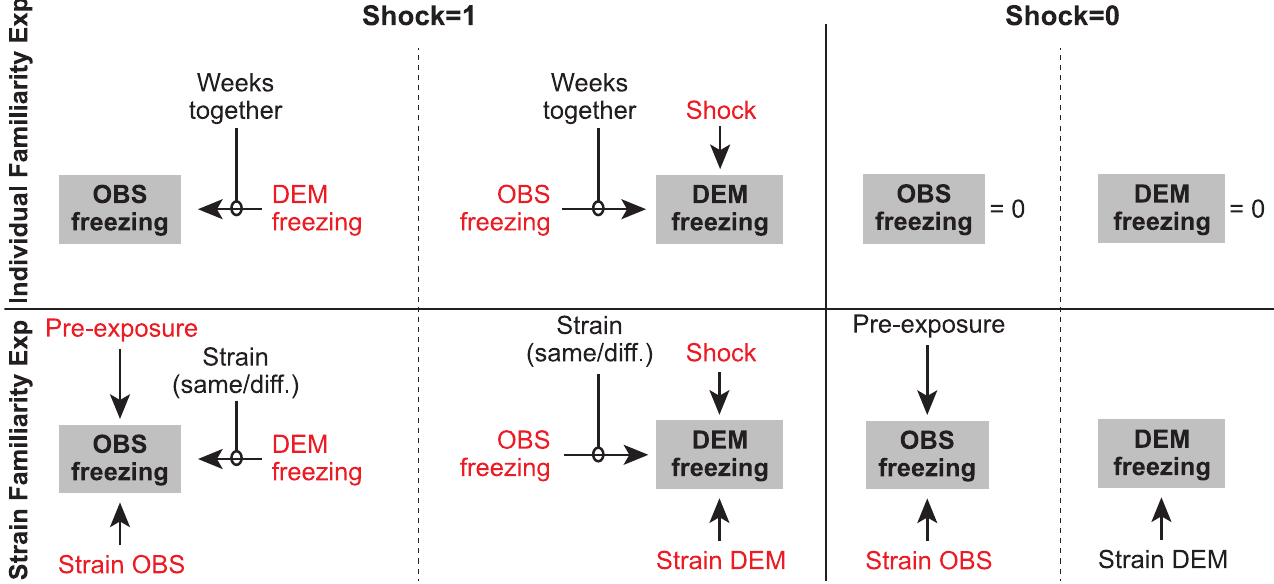
Fig 4. Variables included in the Bayesian models. Several models were built, separately for the individual and strain familiarity experiments, based on the factors that could describe the observer and demonstrator freezing. Here, the full models for the individual familiarity experiment (top) and strain familiarity experiment (bottom) are shown separately for epochs in which shocks are delivered (shock = 1) and those in which no shocks are delivered (shock = 0). The target variables that the models explain are shown in a gray box. These full models were then compared against simplified models, and the variables included in the winning model are shown in red. The modulator “Weeks together” captures whether the effect across animals depends on the number of weeks the observer and demonstrator spent together before testing (i.e., 0, 1, 3, 5 weeks). This modulator was implemented in two different ways (see Table 1A and 1B, and Fig 5): (1) in a way that models a linear increase of interindividual influence with number of weeks spent together, with the impact thus five times stronger after 5 compared with 1 week spent together, or (2) in a way that simply models a different connection weight for each group. Strain OBS and strain DEM capture the effect of a particular strain on the average freezing level of that strain. Strain (same/diff.) is a binary variable indicating whether the observer and demonstrator dyad were of the same or different strain. Finally, the variable preexposure indicates the amount of freezing of the observer during preexposure. Unfortunately, we only collected movies during preexposure in the strain familiarity experiment and thus cannot retrospectively include that variable in the models of the individual familiarity experiment. Data can be found at http://dx.doi.org/10.17632/h8fkyr2z35.1. DEM, demonstrator rat; diff., different; Exp, experiment; OBS, observer